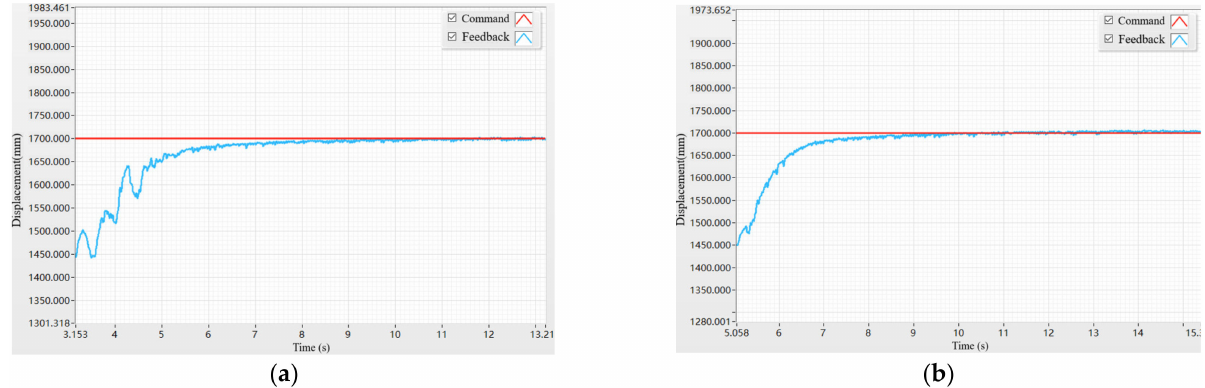
Figure 19. ( a ) Step response displacement curve of PID; ( b ) Step response displacement curve of ADRC.